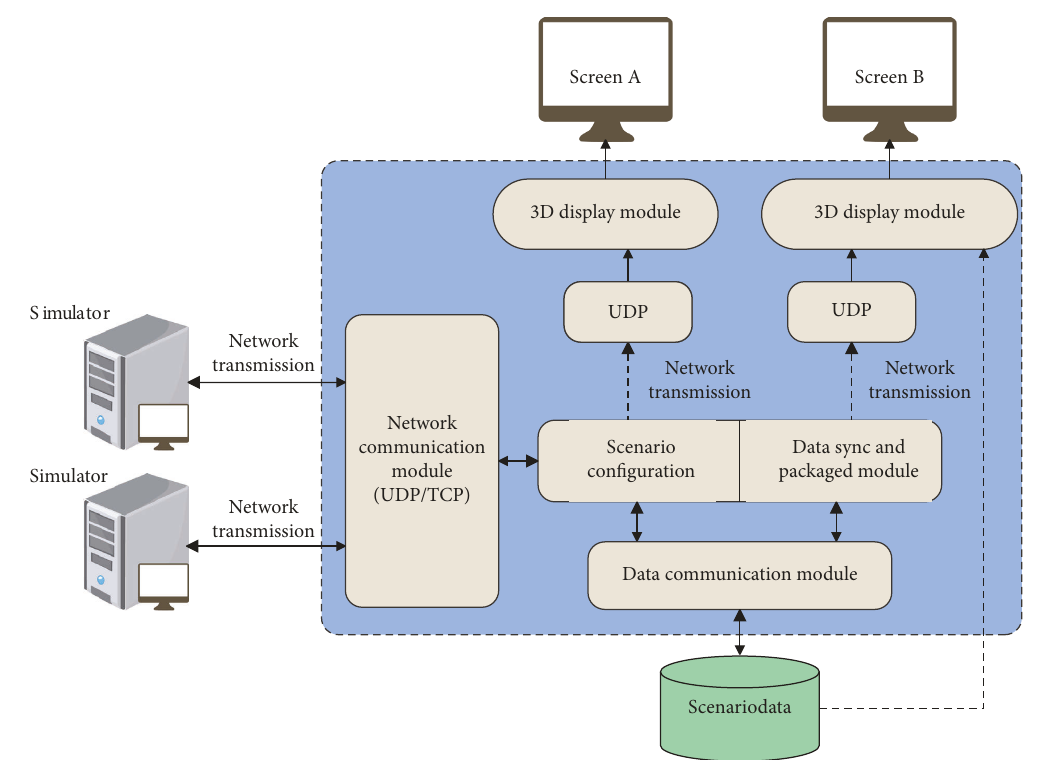
Figure 5: Simulation design module of real-time